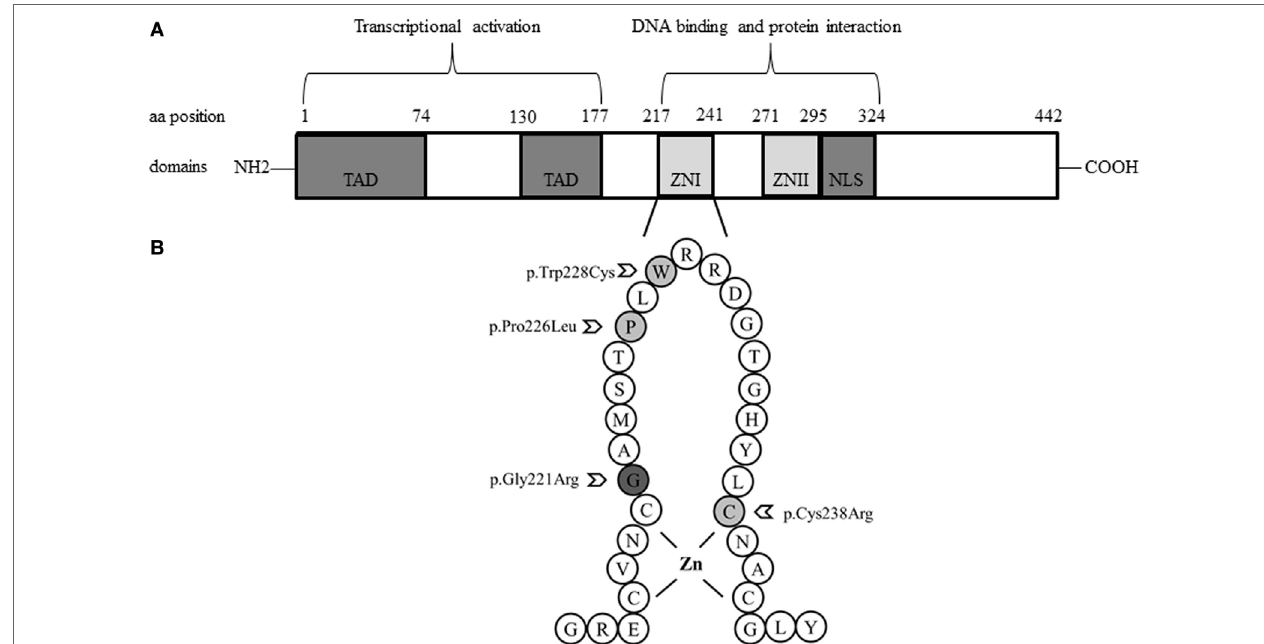
FigUre 1 | Schemes of the structure of the GATA4 protein and localization of studied variations. (a) . GATA4 contains two distinct zinc finger domains (ZNI and ZNII) and a C-terminal nuclear localization sequence (NLS), which consists of a DNA-binding domain and a protein–protein interaction domain. Transcriptional activation domains (TAD) are located in the N-terminus. (B) . Close-up loop of the ZNI domain of the C-terminus, where all GATA4 variations described so far in patients with a 46,XY phenotype are located: Gly221Arg, Pro226Leu, Trp228Cys, and